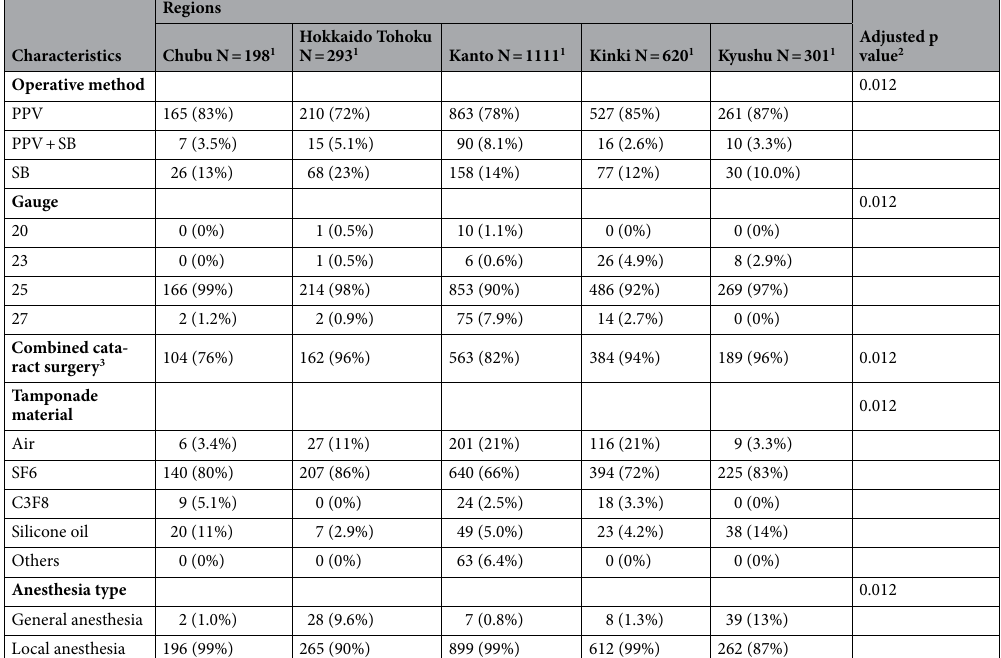
Table 2. Operative background of subjects by regions. 1 n (%). 2 Fisher’s Exact Test for Count Data with simulated p-value. Holm correction for multiple testing. 3 Among phakic patients who got vitrectomy without scleral